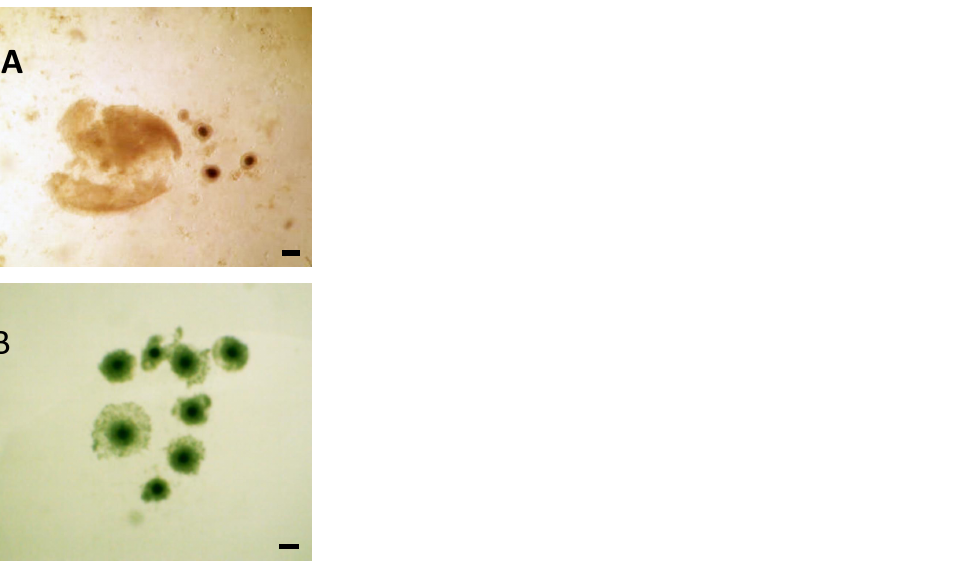
Table 1. Meiotic development of oocytes from poly-ovular ( p ) and mono-ovular (M) follicles throughout the estrus cycle in dogs.